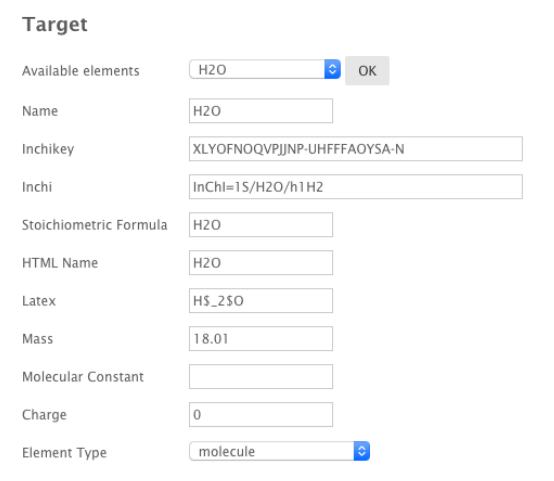
Figure A1. Extract from the webUI for the creation of an “Element” input file (Table A1). In this example, the information related to the H 2 O species is retrieved from BASECOL.